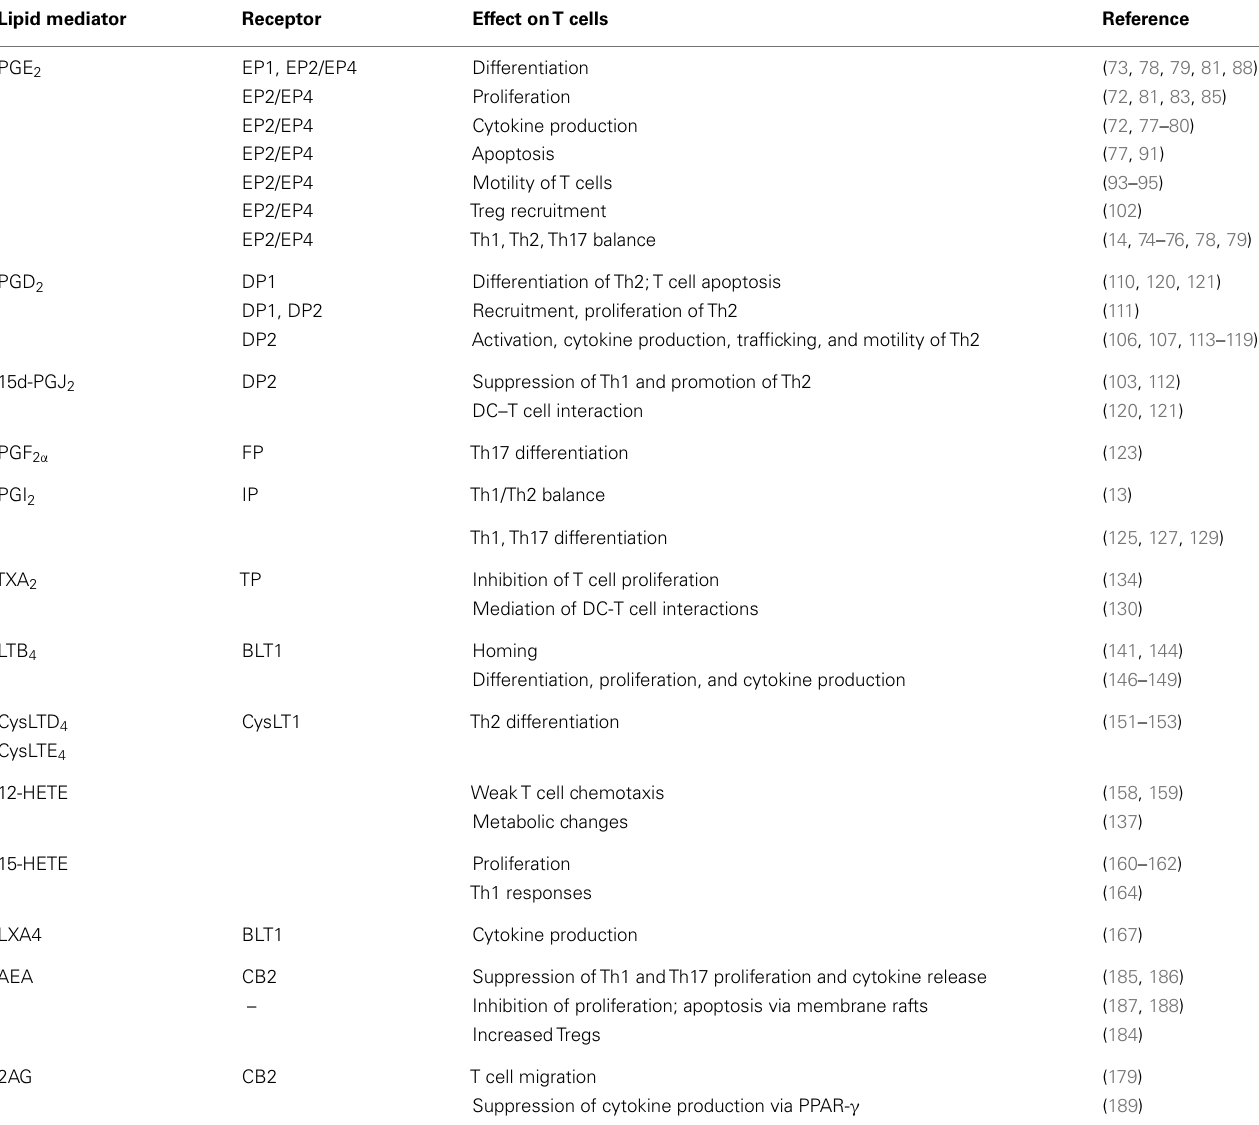
Table 1 | Summary of the main immunoregulatory roles of bioactive lipid mediators related toT cell function and biology . Lipid